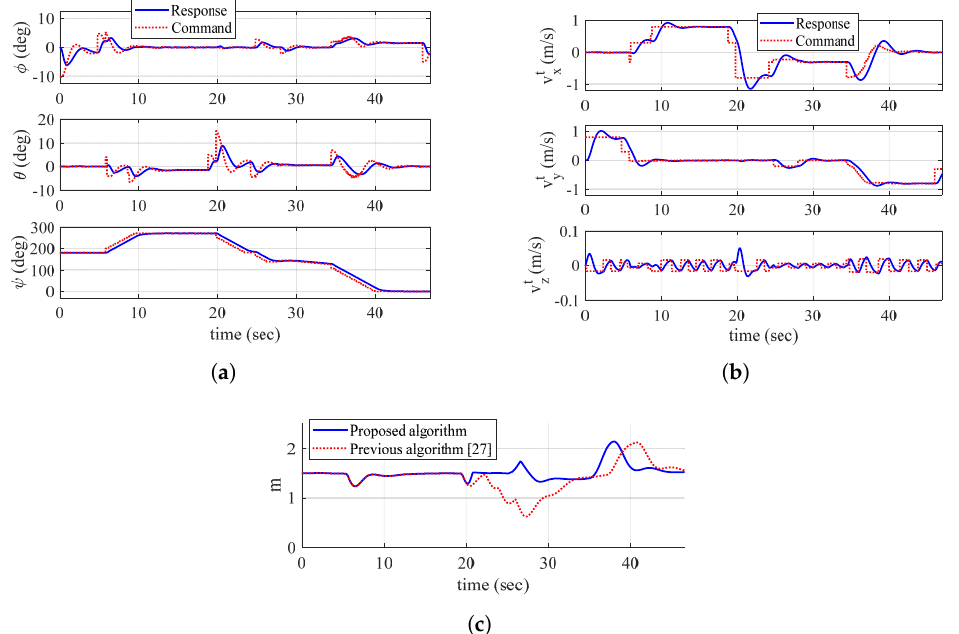
Figure 9. Time histories of UAV-related parameters (Simulation II): ( a ) attitude; ( b ) velocity (tangent–plane coordinate system); and ( c ) minimum distance between UAV and